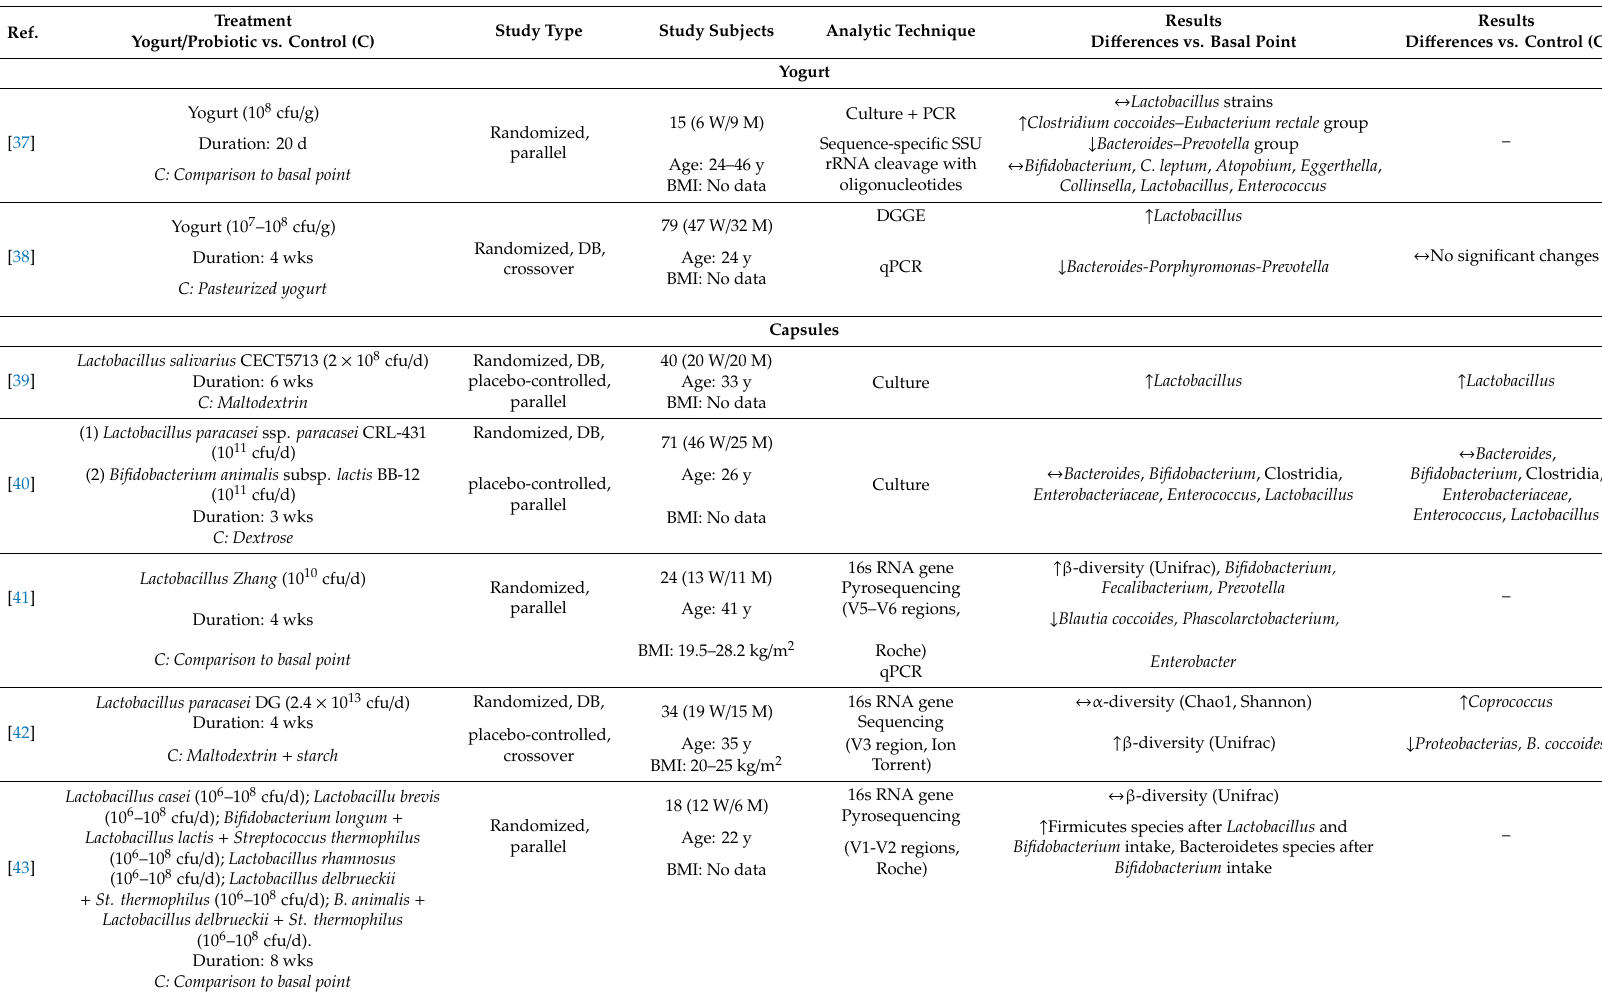
Table 1. Evidence from human studies relative to yogurt and probiotics e ff ects on the gut microbiota composition of healthy adults.